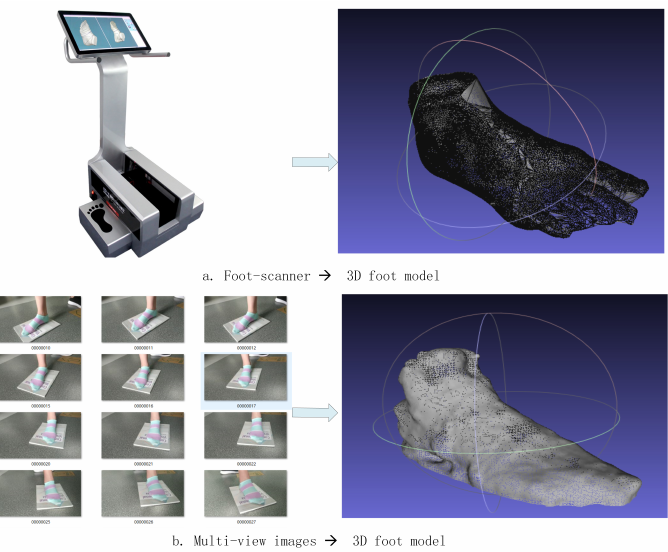
Figure 8. 3D foot model comparison of foot-scanner and